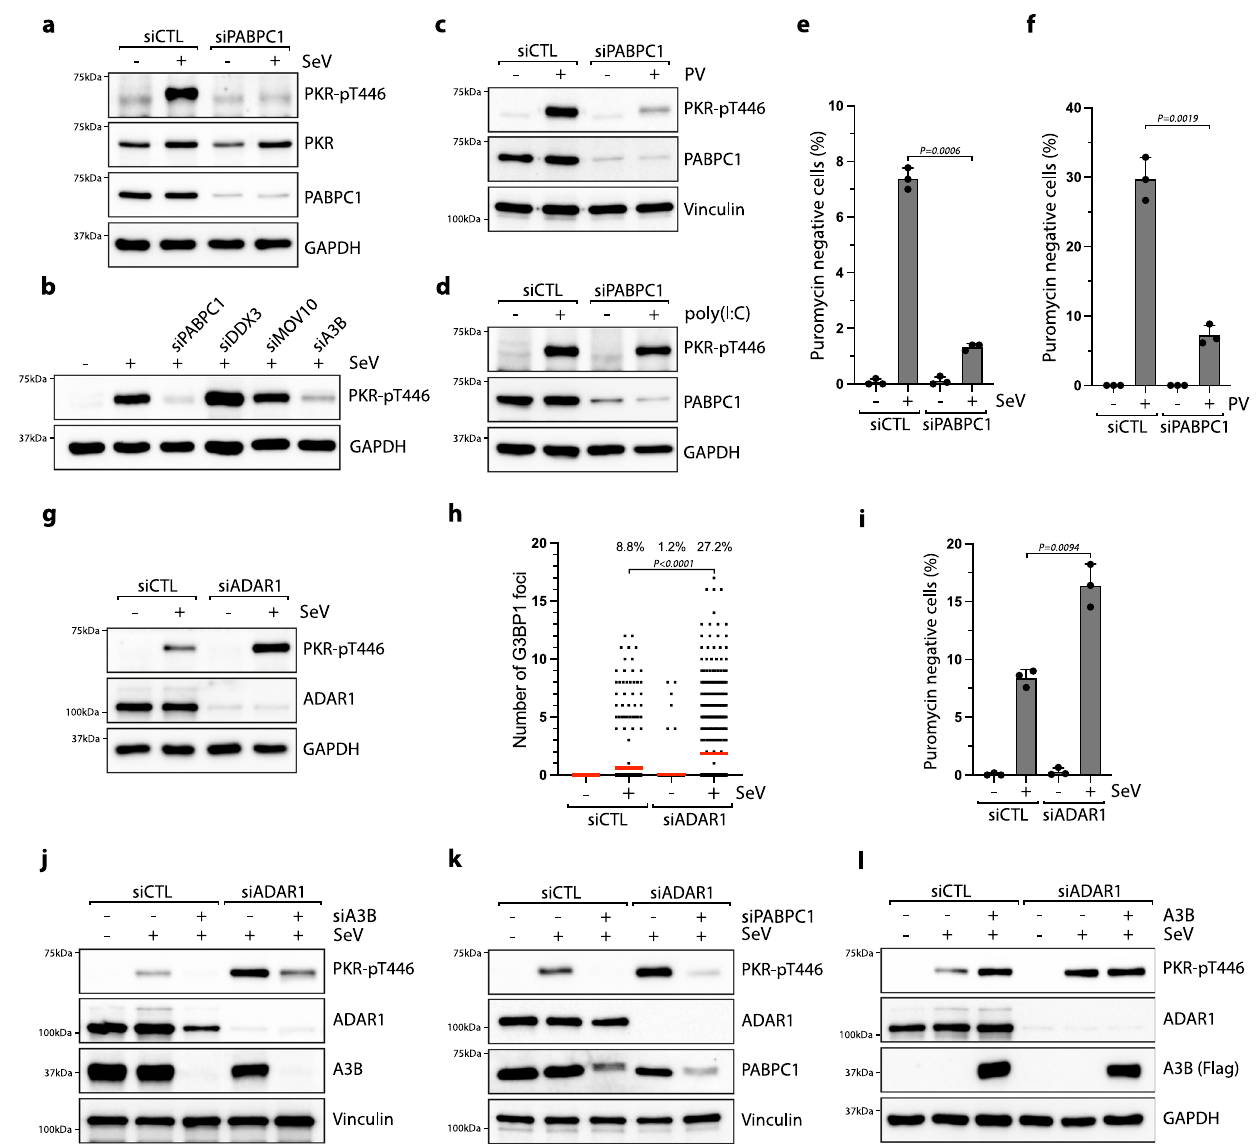
Fig. 5 | APOBEC3B and PABPC1 counterbalance ADAR1 activity suppressing PKR. a, b U2OS cells knocked down for 40h with the indicated siRNAs were infected with SeV (MOI=1, 24hpi) and the levels of PKR-pT446 and the indicated proteinswereanalyzedbywesternblotting.U2OScellsknockeddownwithasiRNA control(siCTL)oragainstPABPC1for40hwereinfectedwithPVatMOI=1for20h ( c ) or transfected with 200ng/mL poly(I:C) for 8h ( d ). The levels of PKR-pT446, PABPC1, and vinculin were analyzed by western blotting. U2OS cells were trans- fected with siRNA against PABPC1 for 40h and subsequently infected with SeV at MOI=1( e )orPVatMOI=1( f ).At24hpi(SeV)or16hpi(PV),thelevelsofpuromycin negative cells (%) were quanti fi ed by immuno fl uorescence. Mean values±SD (Number of biological replicates, n =3). P -values were calculated with a two-tailed Welch t -test. g – i . U2OS cells knocked downwith a siRNA control (siCTL) oragainst